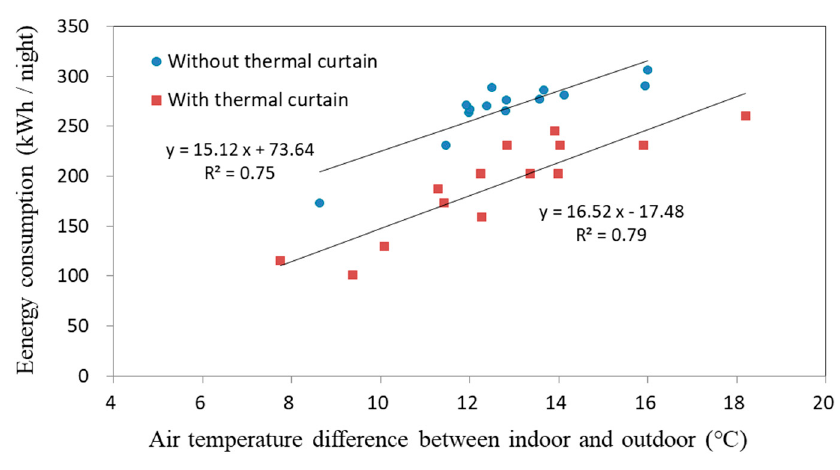
Figure 7. Energy consumption as a function of the indoor and outdoor air temperature difference without and with thermal curtains.